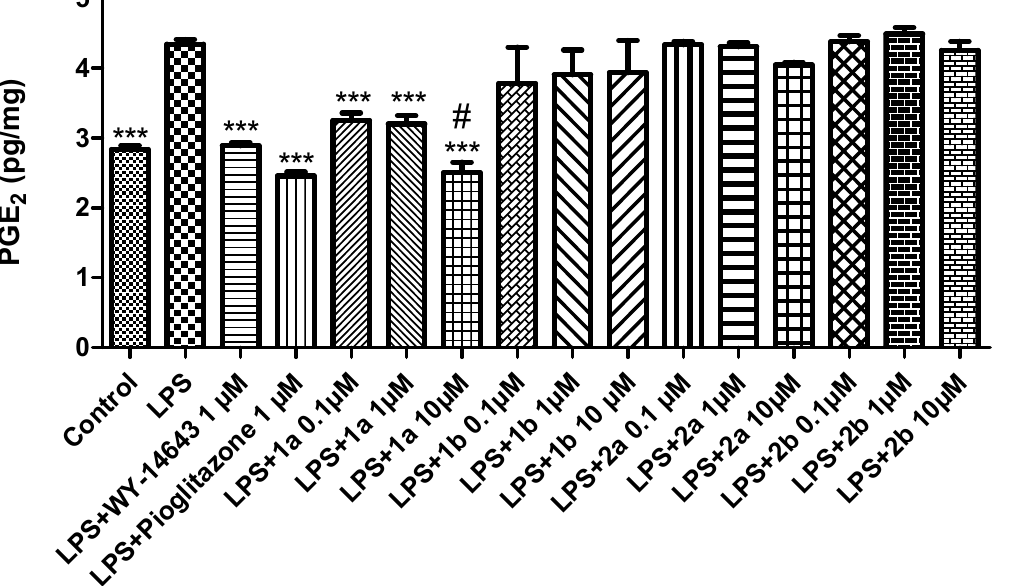
Figure 4. The effects of WY ‐ 14643 (1 μ M), pioglitazone (1 μ M), and 1a ‐ b and 2a ‐ b (0.1–10 μ M), on the LPS ‐ induced LDH activity (nmol/l) in rat liver, ex vivo . Data were reported as means ± SEM. The results were analyzed by analysis of variance (ANOVA) followed by the Newman–Keuls post ‐ hoc test. ANOVA, p < 0.0001; post ‐ hoc *** p < 0.001 vs. LPS ‐ treated group; # p < 0.05 vs. LPS + WY ‐ 14643.